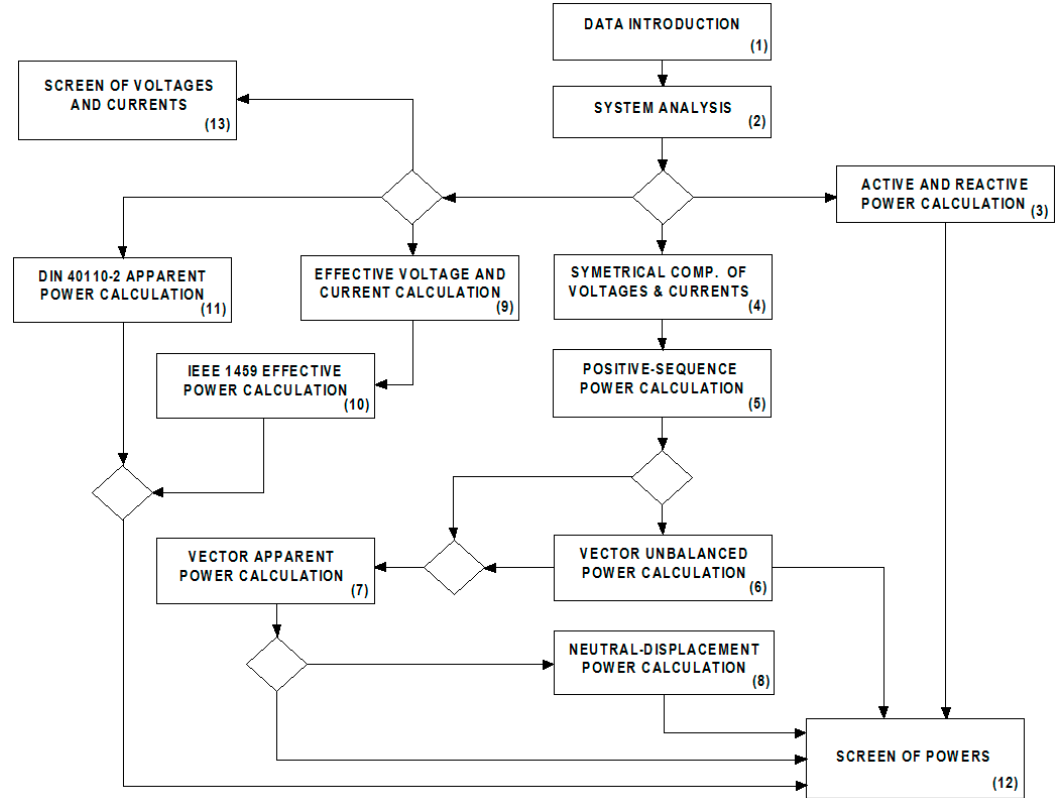
Figure 5. Operational diagram of the EPC software.